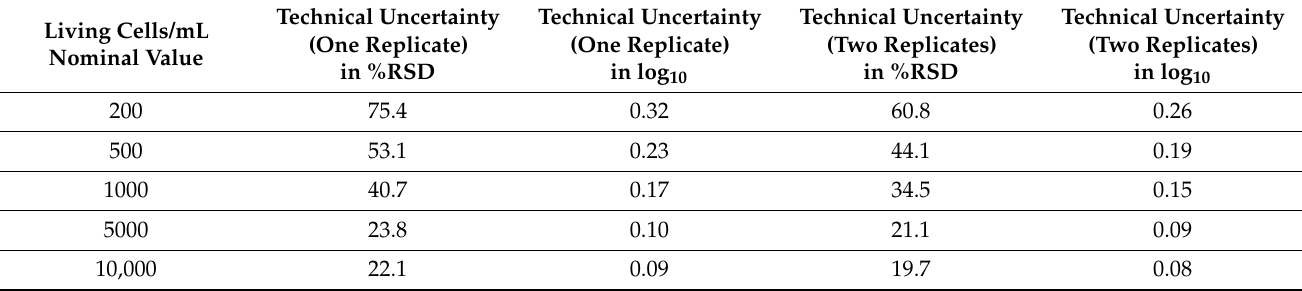
Table 11. Obtained technical uncertainty for Supermix with